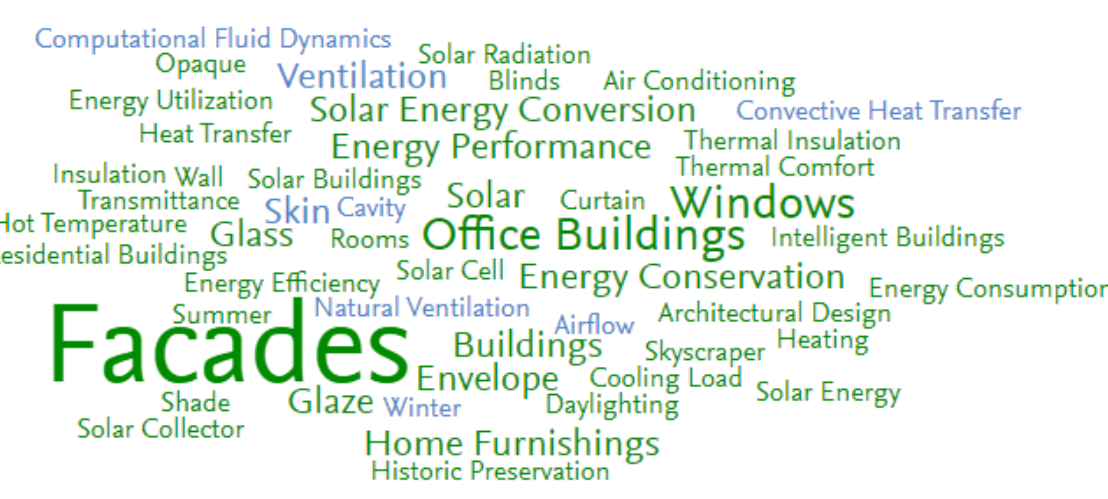
Figure 2. Visualization of scientific landscapes by indexed keywords, SCOPUS (VOS Viewer).